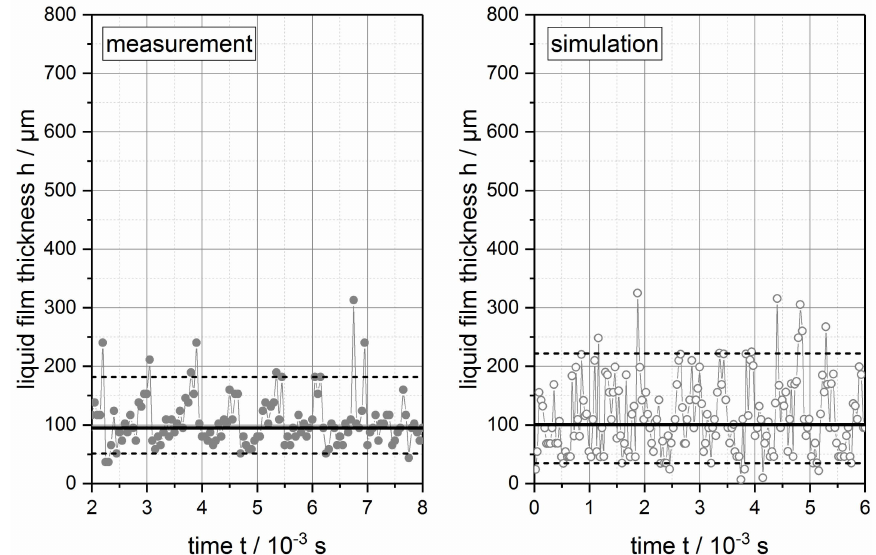
Figure 10. Time dependent values of measured ( left , grey dots) and simulated ( right , grey rings) film thickness h at µ = 0.12 Pa · s and ALR = 0.15 (Q L = 30 L · h − 1 ; p gas = 0.6 MPa). Additionally, x 5,0 (lower dashed line), x 50,0 (solid line) and x 95,0 (upper dashed line) of the liquid film thickness are given.